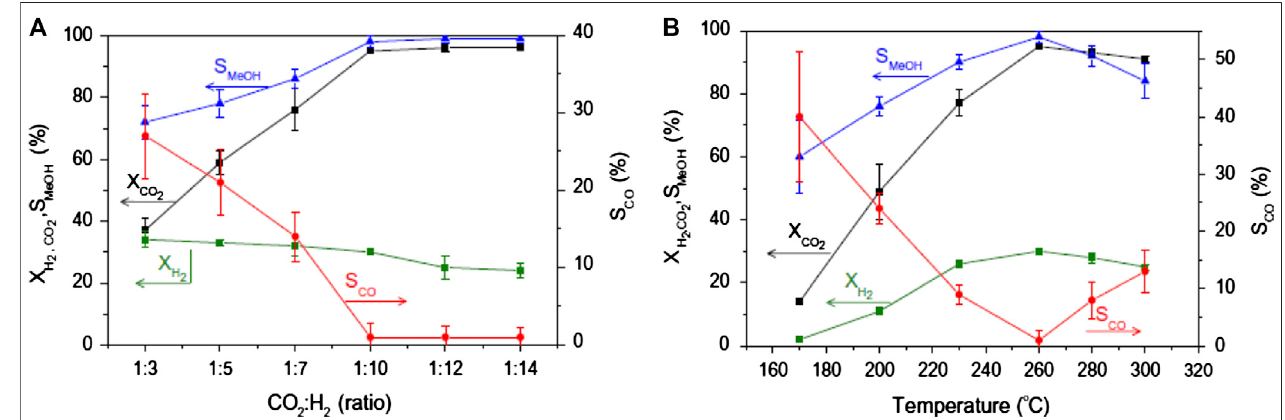
) , conversion of H ( X ) and selectivity to CO (S H 2 2 2